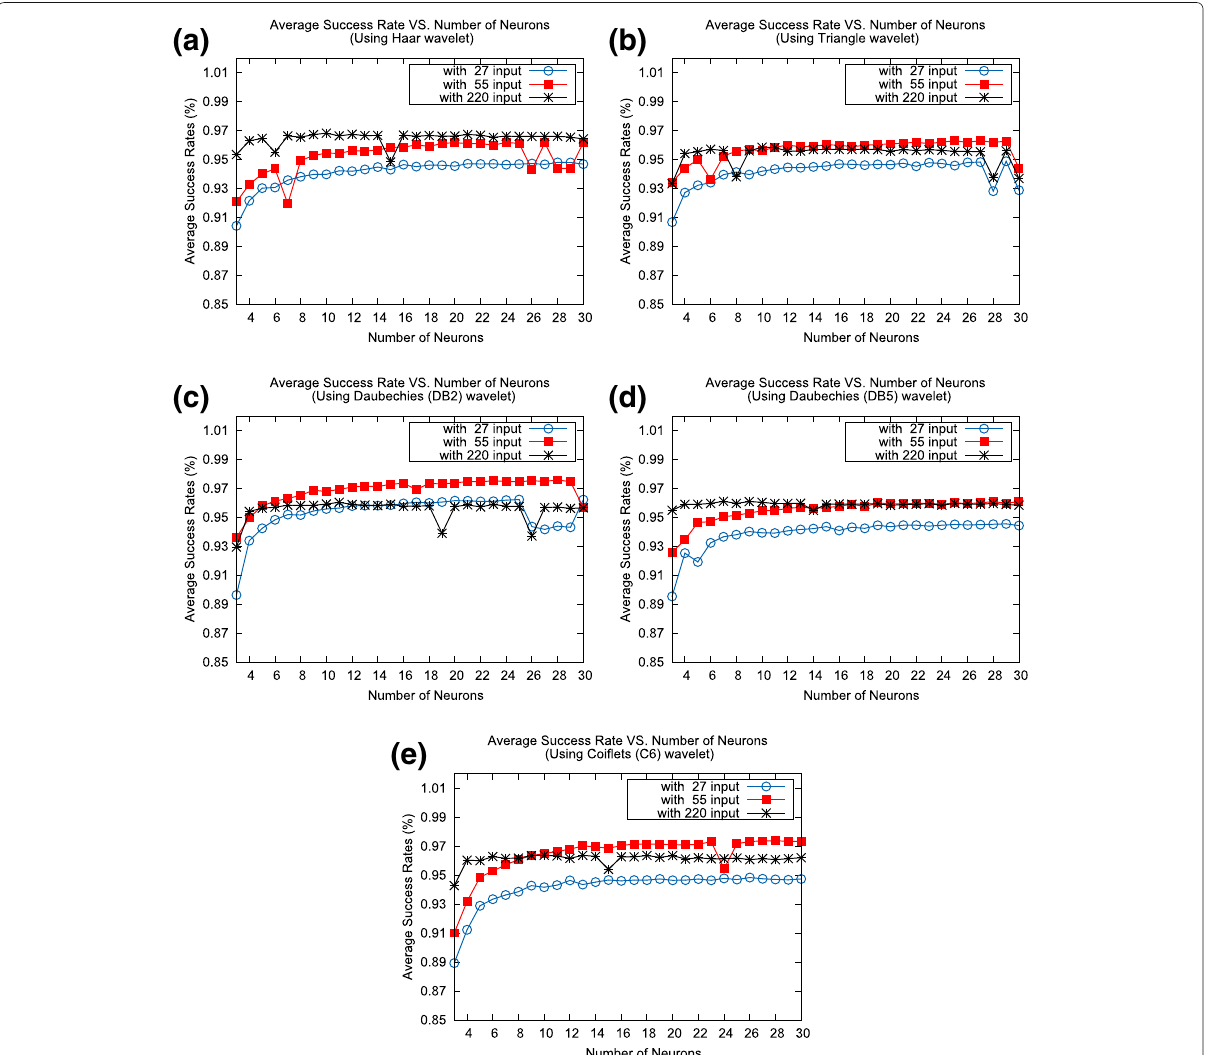
Fig. 8 The probability of correct classification (average success rate) vs. number of hidden neurons by using different wavelet transforms and various input size in an AWGN channel. a Haar wavelet, b Triangle wavelet, c Daubechies (DB2) wavelet, d Daubechies (DB5) wavelet, e Coiflets (C6) wavelet